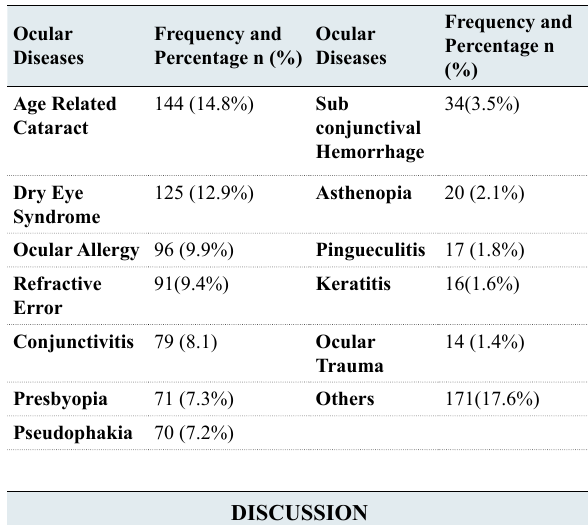
Table 2: Frequency of ocular diseases among the study